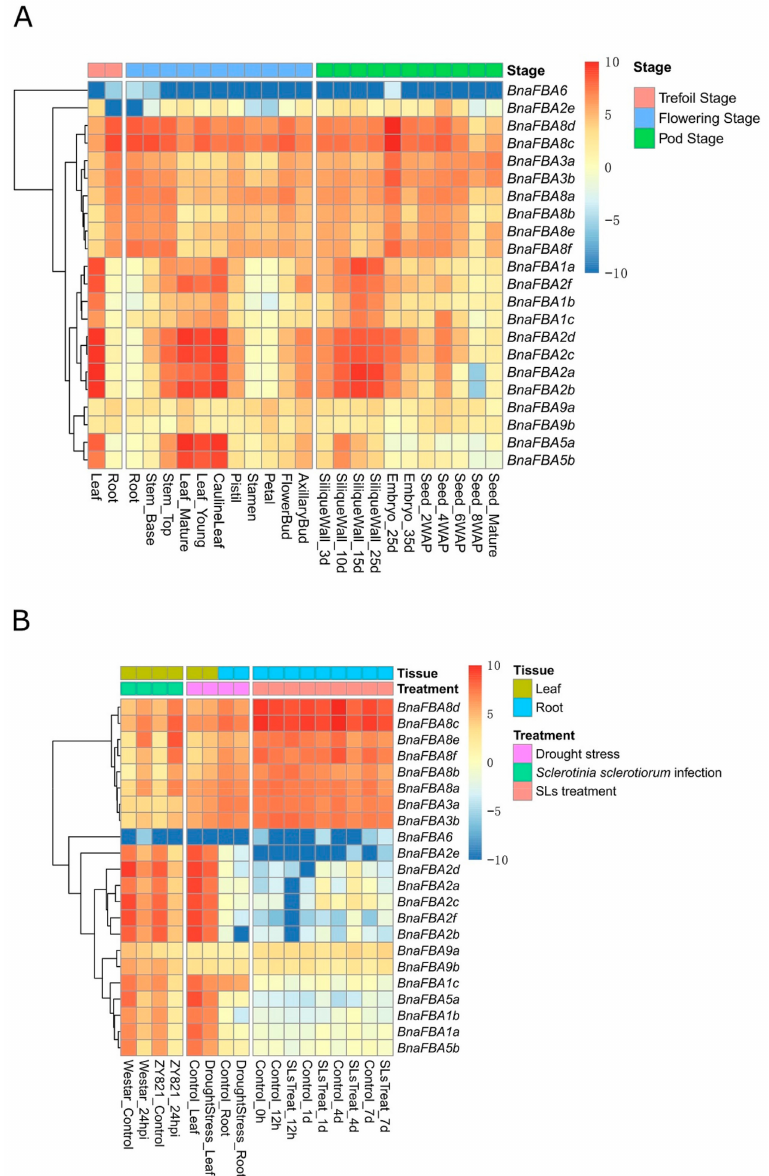
Figure 6. Expression analysis of the 22 BnaFBA genes in B. napus . ( A ) Expression patterns of the BnaFBA genes in various tissues at di ff erent developmental stages. The color bar represents log2 expression levels (FPKM, fragments per kilobase of exon per million fragments mapped) of each gene. ( B ) Expression patterns of the BnaFBA genes under drought stress, Sclerotinia sclerotiorum infection, and strigolactones treatments in B. napus . The color scale of heatmap indicates expression values, with blue-white and red representing low and high levels of transcript abundance, respectively. The cluster tree of BnaFBA genes, based on the expression level, is shown on the